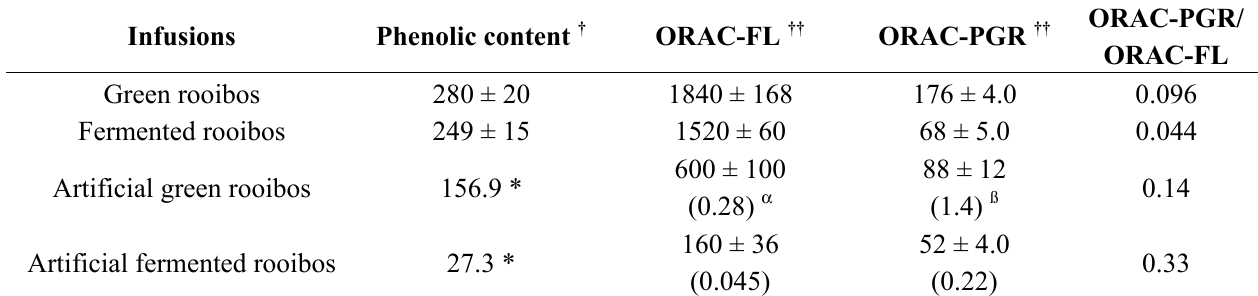
Table 3. Total phenol content and ORAC indices of natural and artificial